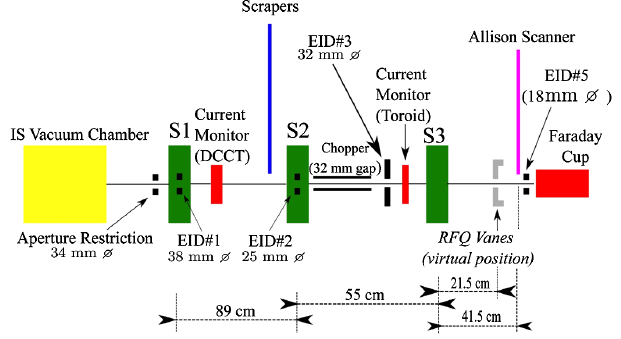
FIG. 8. M OLFLOW simulation of the axial pressure longitudinal distribution in the ion source region of the PIP2IT LEBT. z ¼ 0 indicates the plasma emitting surface. An H 2 gas flow of 15 sccm was